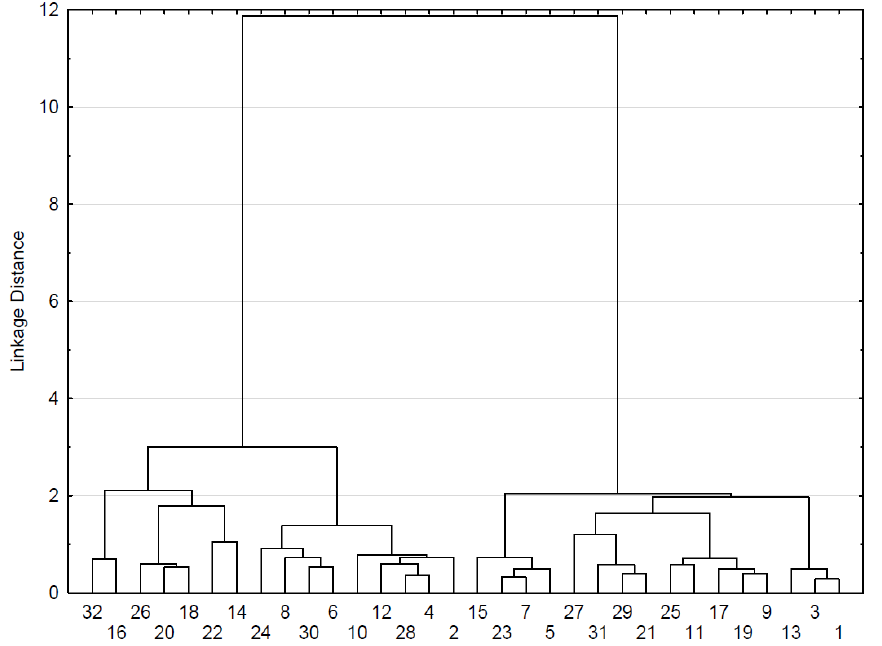
Figure 3. HCA analysis of all 32 onion samples deriving from 32 treatments (for the legend, see Appendix